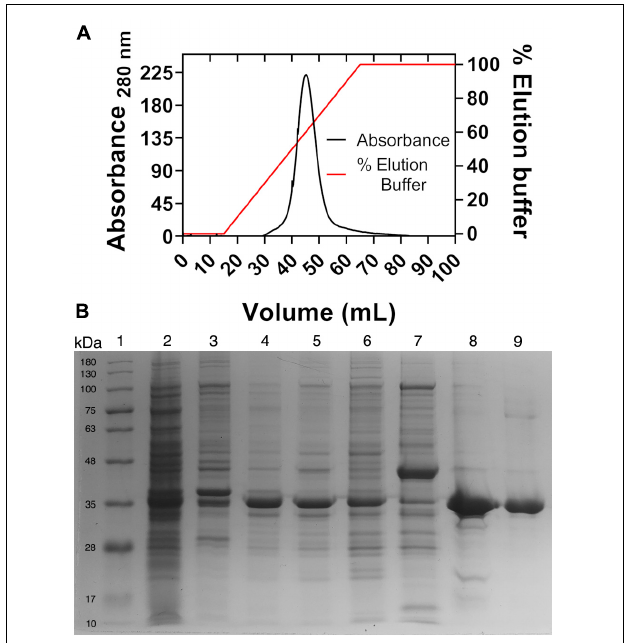
FIGURE 1 | Metal ion affinity chromatography and SDS-PAGE. (A) Nickel affinity chromatography. The right axis indicates the percentage of the elution buffer, 100% equal to 250 mM of imidazole. (B) SDS-PAGE of purified recombinant glucose-6-phosphate dehydrogenase from Haloferax volcanii ( Hv G6PDH). Lane 1, molecular mass marker; 2, pellet; 3, insoluble fraction; 4, insoluble fraction solubilized with urea; 5, refolded protein; 6, chromatographic front; 7, wash; 8, purified protein precipitated with trichloroacetic acid to remove excess salt; and 9, purified protein after salt remotion by ultrafiltration. Moreover, 10 µ g of protein was loaded into each